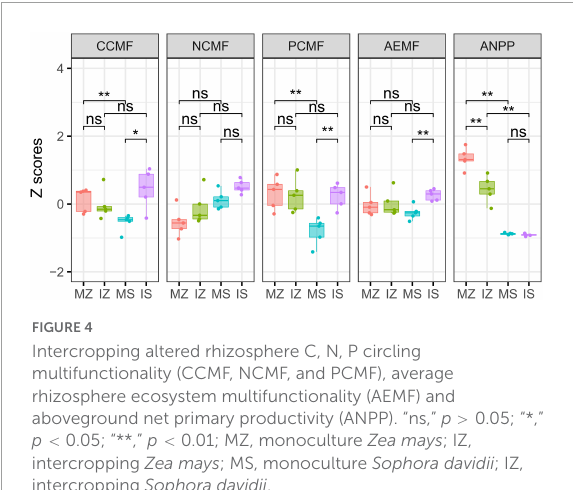
FIGURE4 Intercropping altered rhizosphere C, N, P circling multifunctionality (CCMF, NCMF, and PCMF), average rhizosphere ecosystem multifunctionality (AEMF)